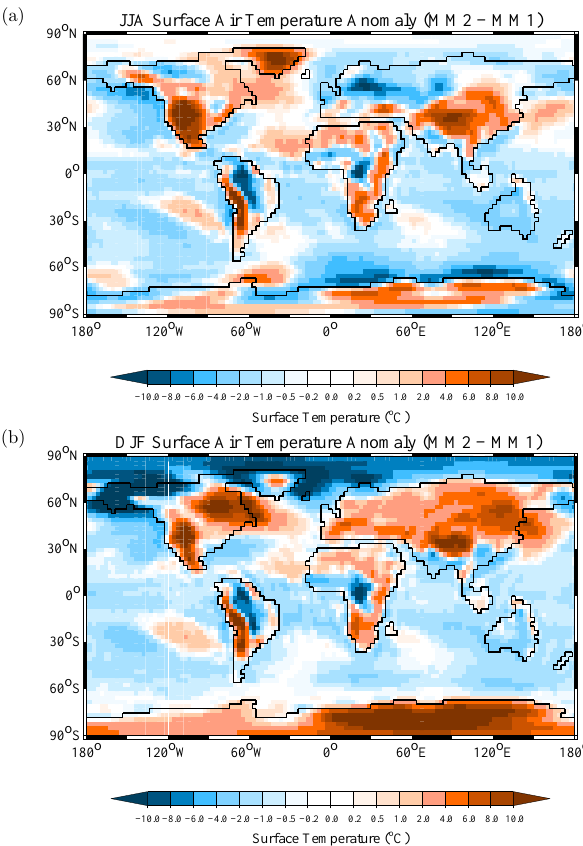
Fig. 7. (a) Annual mean surface temperature and (b) precipitation anomalies between experiments MM2 and MM1. Only the precip- itation anomalies greater than one standard deviation for the long- term annual mean over the last 20 simulation years are shown.